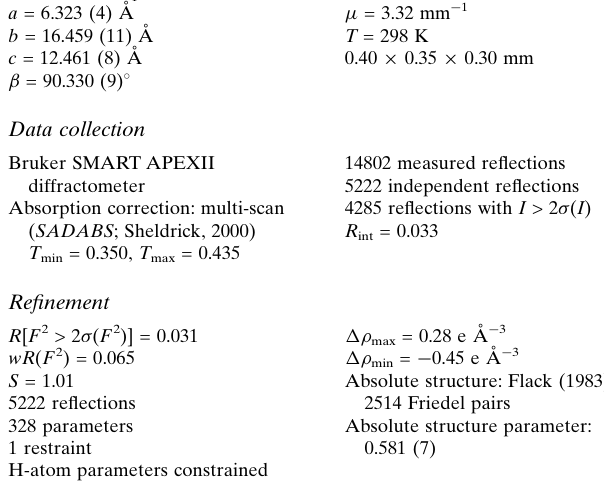
The title compound, C